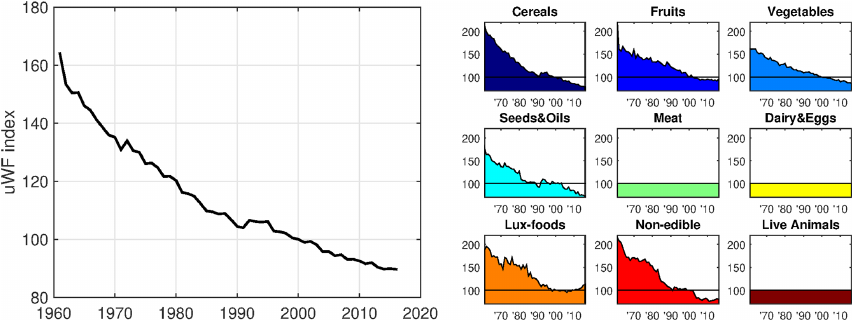
Figure 6. Temporal variability of uWF indexes weighted with agricultural production (solid) and export (with dots) in the year 2000, aggregated across all goods (left) and (right) split into the nine categories of goods.